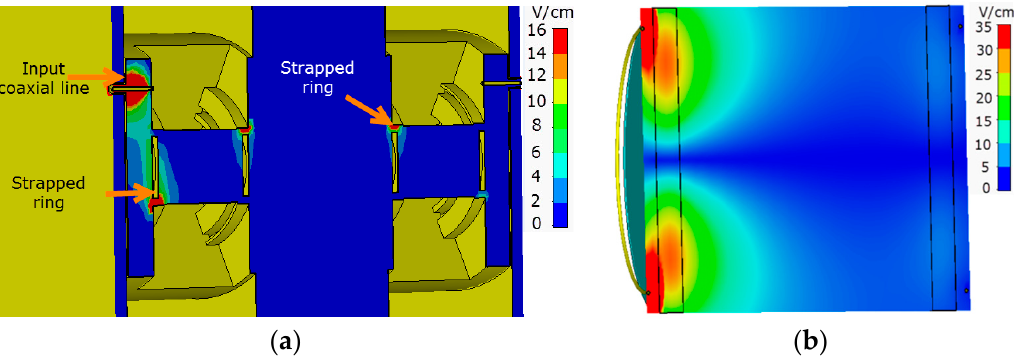
Figure 9. Electric field distribution ( a ) Field distribution in the system based on SR. ( b ) Electric field distribution in the system based on DR.